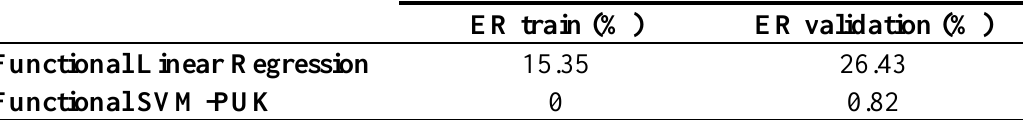
Table 1. Mean training and validation error rates (percentage of poorly classified observations) for the two